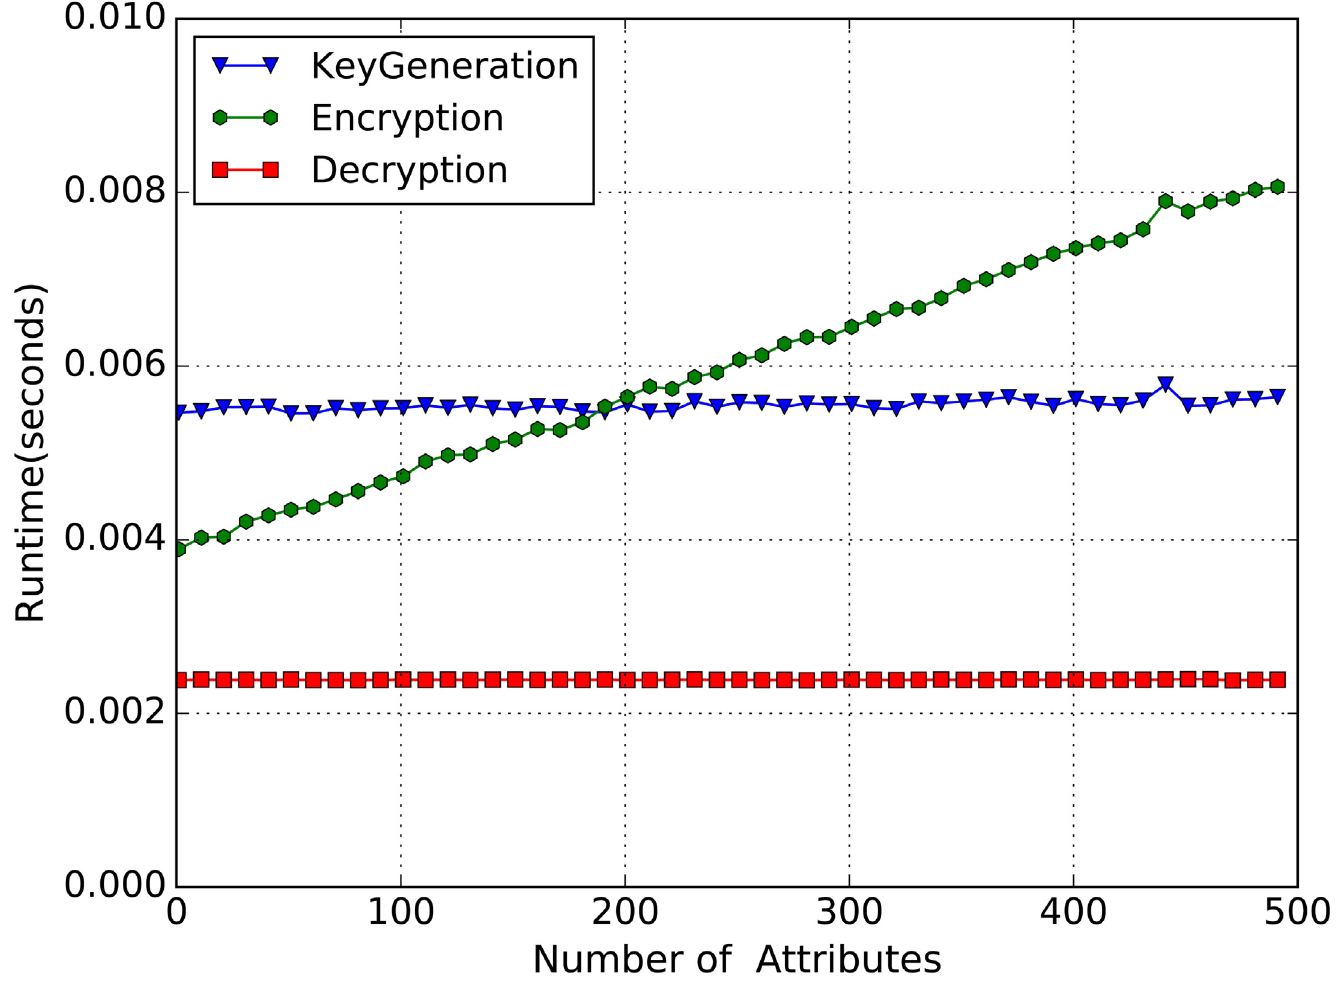
Fig 4. The performance of